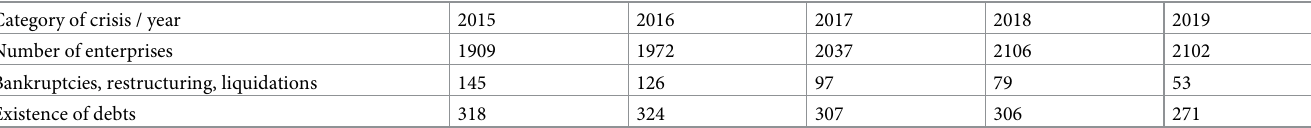
Table 1. An analysis of the number of companies in the engineering industry.